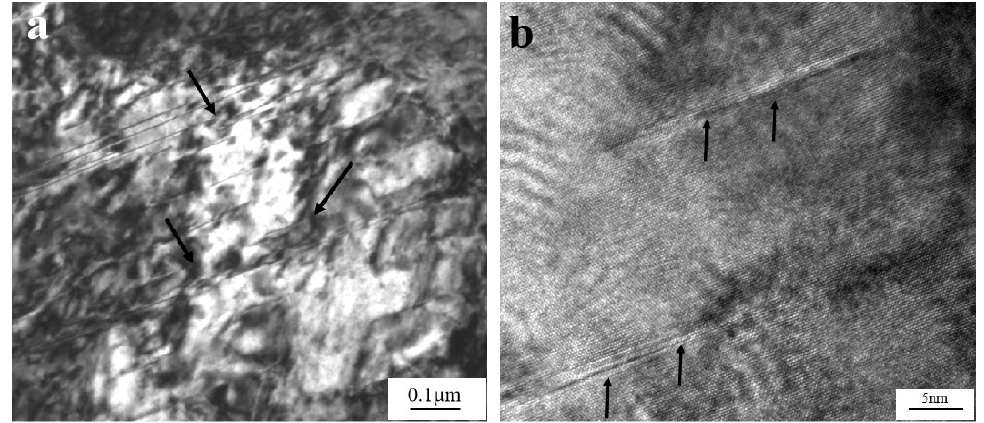
Figure 2. ( a ) Stacking faults in the matrix of W f /Cu 82 Al 10 Fe 4 Ni 4 composites after dynamic compression at 20 °C with the strain rate of 1600 s −1 and ( b ) HREM morphology of stacking faults within the matrix of W f /Cu 82 Al 10 Fe 4 Ni 4 composites. Figure 2b depicts the high-resolution electron microscope (HREM) (FEI, Hills-